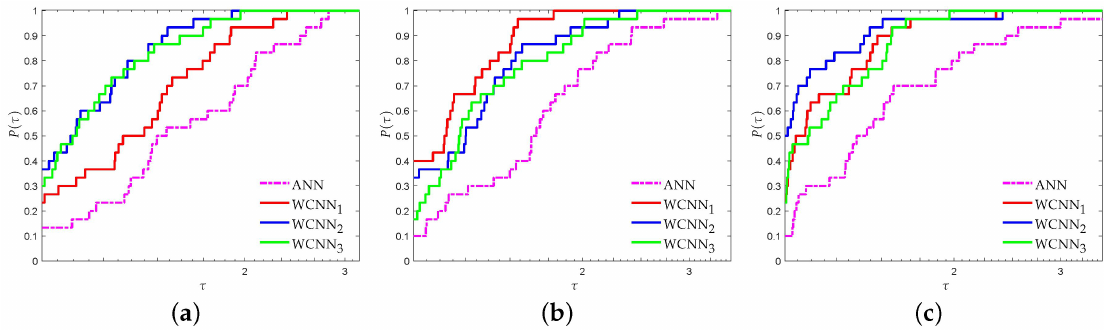
Figure 6. Performance profiles based on RMSE for foreign tourists arrivals (log 10 scaled). ( a ) Forecasting horizon = 6; ( b ) Forecasting horizon = 9; ( c ) Forecasting horizon = 12.